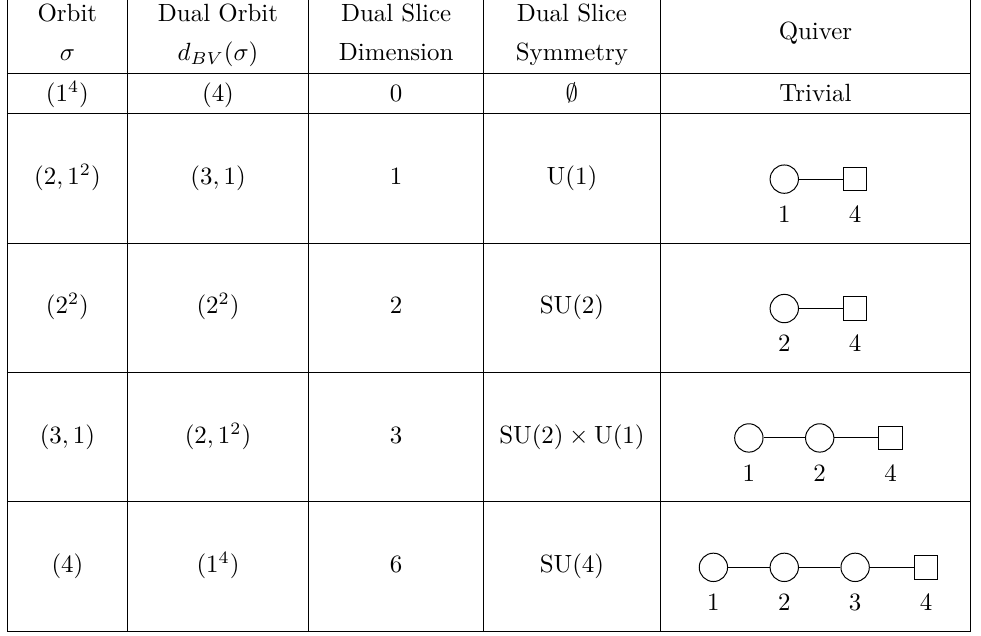
Table 22. T (SU(4)) linear quivers. These quivers correspond to untwisted A 3 punctures. All the